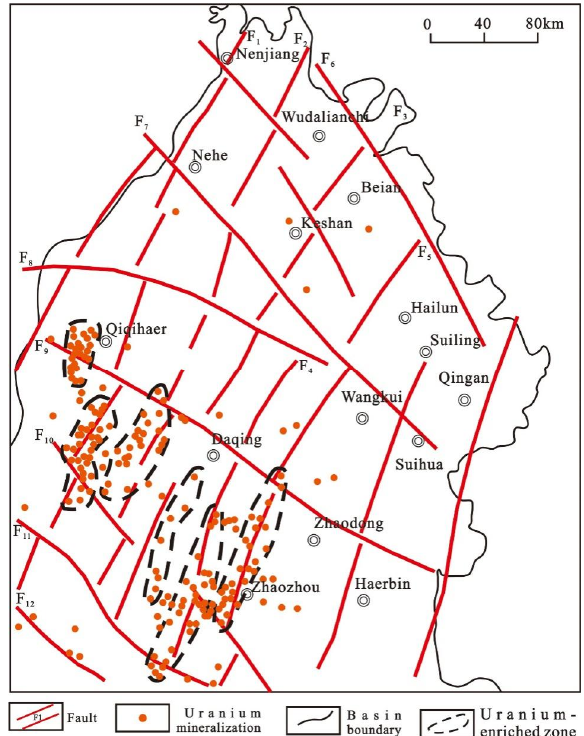
Figure 14. Relationship between basement fractures and uranium mineralization in the northern part of the Songliao Basin (based on [66], slightly